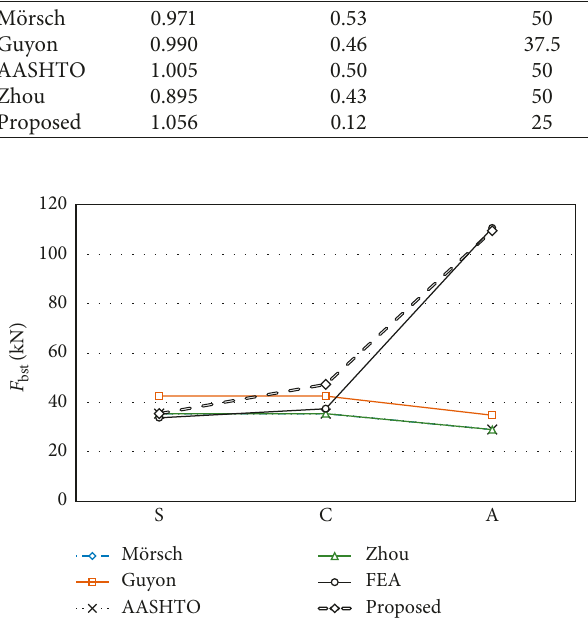
Figure 11: Evaluation of the proposed equation on the anchorage